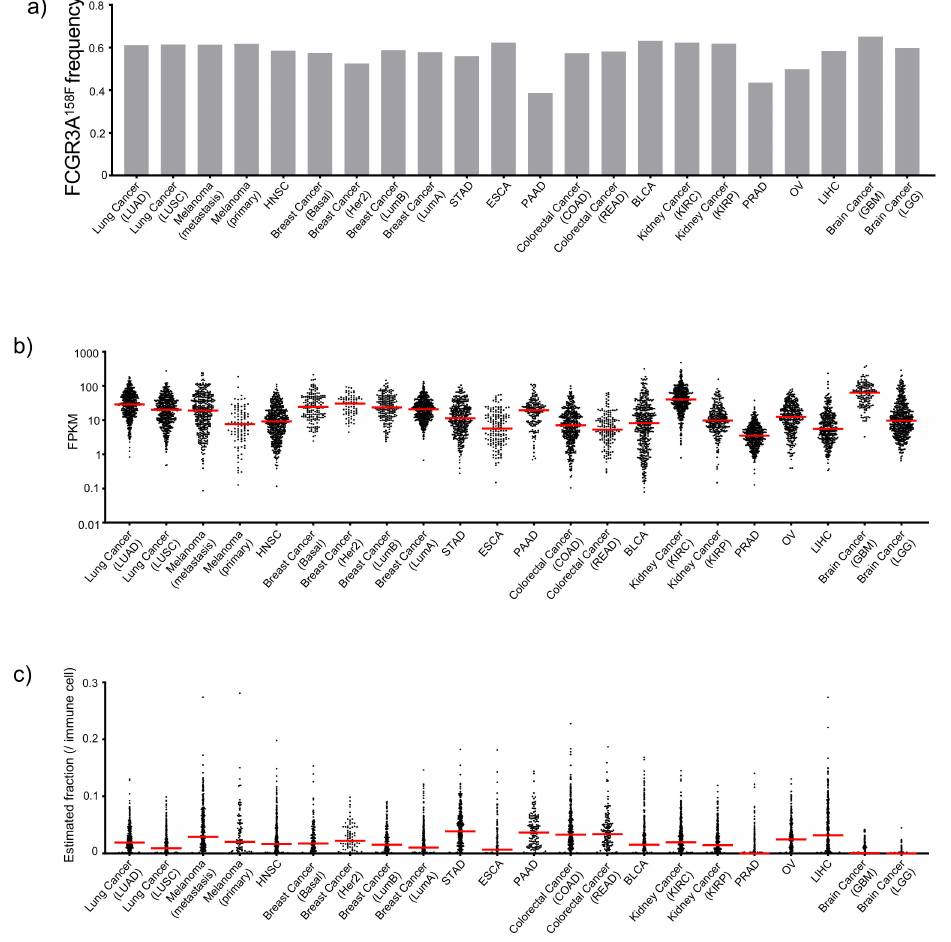
Figure 3. Mining genomic and RNAseq data for ADCC features of 22 cancer types in The Cancer GenomicsAtlas(TCGA)database. ( a )Allelefrequencyof FCGR3A 158 F . ( b )Dotplotshowingthe FCGR3A gene expression. ( c ) Dot plots showing the estimated fraction of Treg cell among tumor-infiltrating leukocytes. Median values of each cancer type are indicated in horizontal